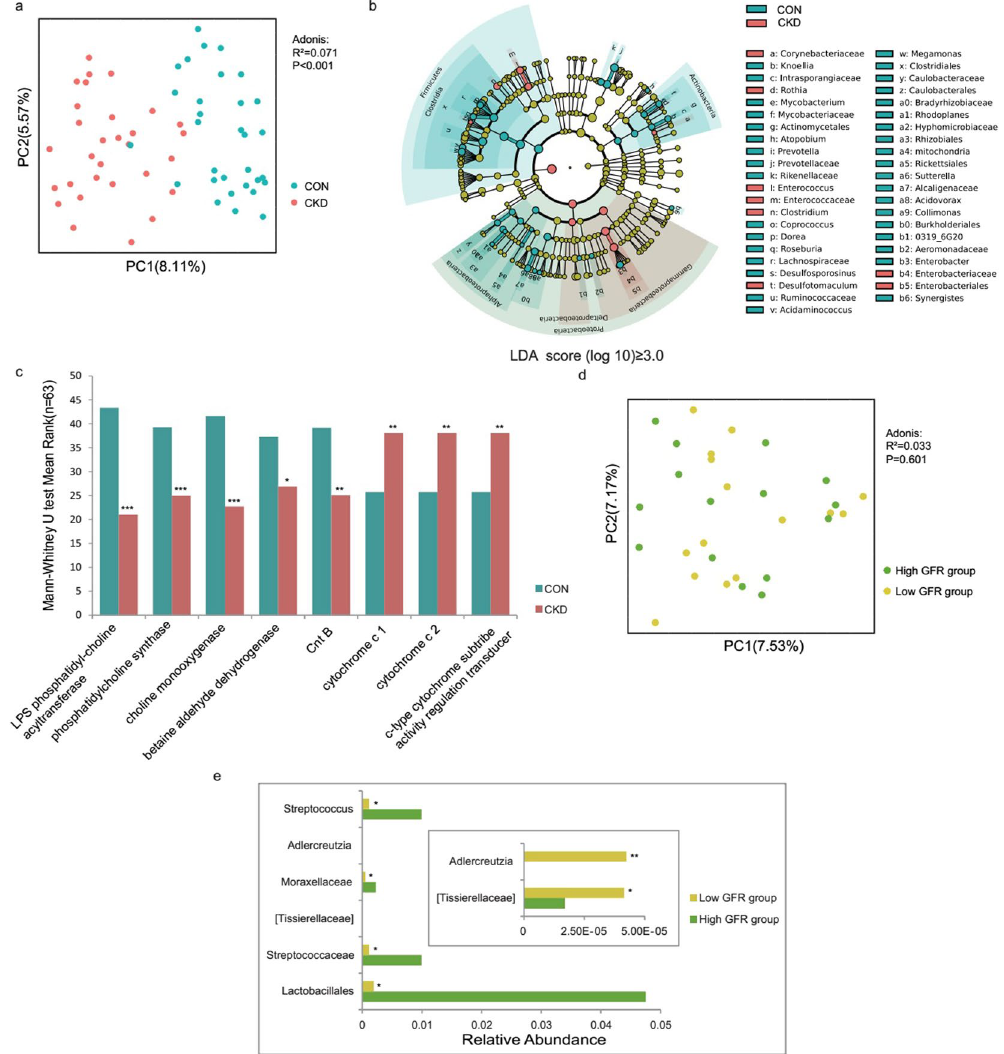
Figure 3. CKD patients showed obvious dysbiosis of the gut microbiome. The data represent the comparison of the gut bacterial profiles between the CKD patients and the healthy controls, including 31 healthy controls (blue) and 30 CKD patients (red). ( a ) Principal coordinate analysis illustrating the grouping patterns of the CKD patient group and the control group based on the unweighted UniFrac distances. Each closed circle represents a sample. Distances between any pair of samples represent their dissimilarities. ( b ) Significantly discriminative taxa between the patients and controls were determined using Linear Discriminant Analysis Effect Size (LEfSe). Only taxa meeting the LDA significance thresholds ( > 3) are shown. Different coloured regions represent different groups. From the interior to the exterior, each layer represents the phylum, class, order, family, and genus level. ( c ) Prediction of gene functions between the CKD patients and the controls. Different coloured bar charts represent different groups. ( d ) Comparison of gut bacterial profiles between two CKD patient subgroups: the high GFR group (GFR ≥ 7 ml/min/1.73 m 2 ) and the low GFR group (GFR < 7 ml/ min/1.73 m 2 ). Principal coordinate analysis illustrating the grouping patterns of the CKD patients based on the unweighted UniFrac distances. The data represent 15 GFR high patients (green) and 15 GFR low patients (yellow). Each closed circle represents a sample. ( e ) Comparison of raw gut mcirobiome data between two CKD patient subgroups. Different coloured bar charts represent different groups. The Mann-Whitney U test was used to determine significance between groups. * P < 0.05; ** P < 0.01; *** P <